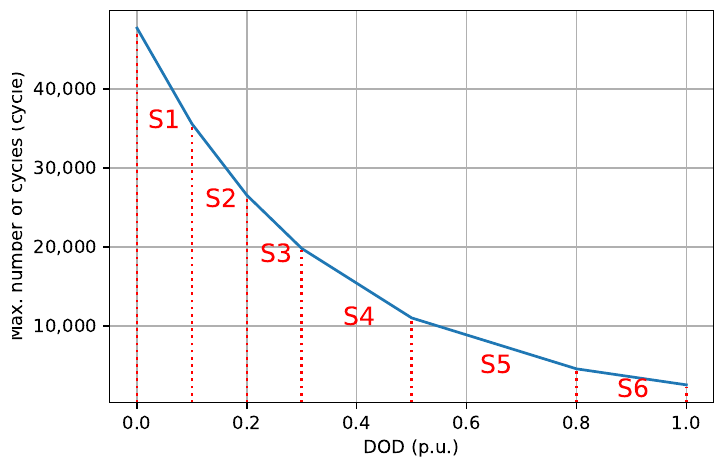
Figure 2. Linear segments of the Li-ion BESS degradation